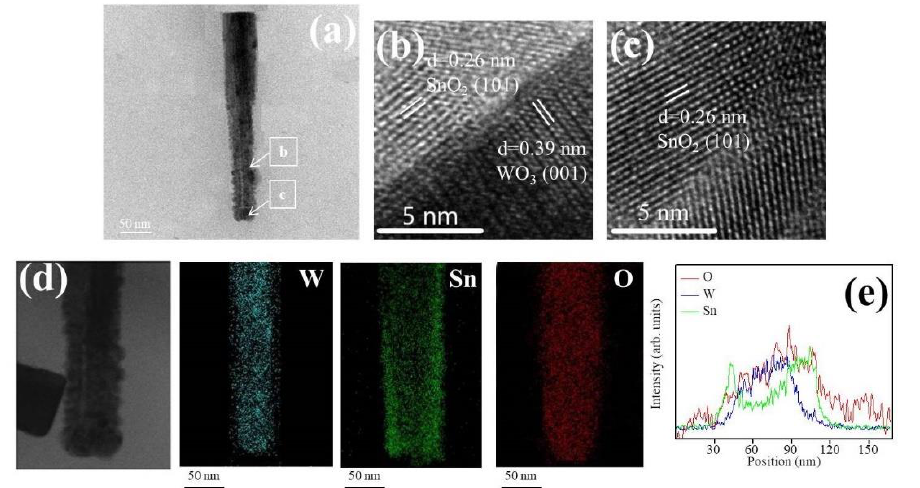
Figure 3. ( a ) Low magnification transmission electron microscopy (TEM) image of a WS-1 nanorod. ( b,c ) High-resolution TEM (HRTEM) images of the nanorod taken from different regions. ( d ) W, Sn, and O elemental mapping images of the nanorod. ( e ) Elemental line-scanning profiles across the nanorod.